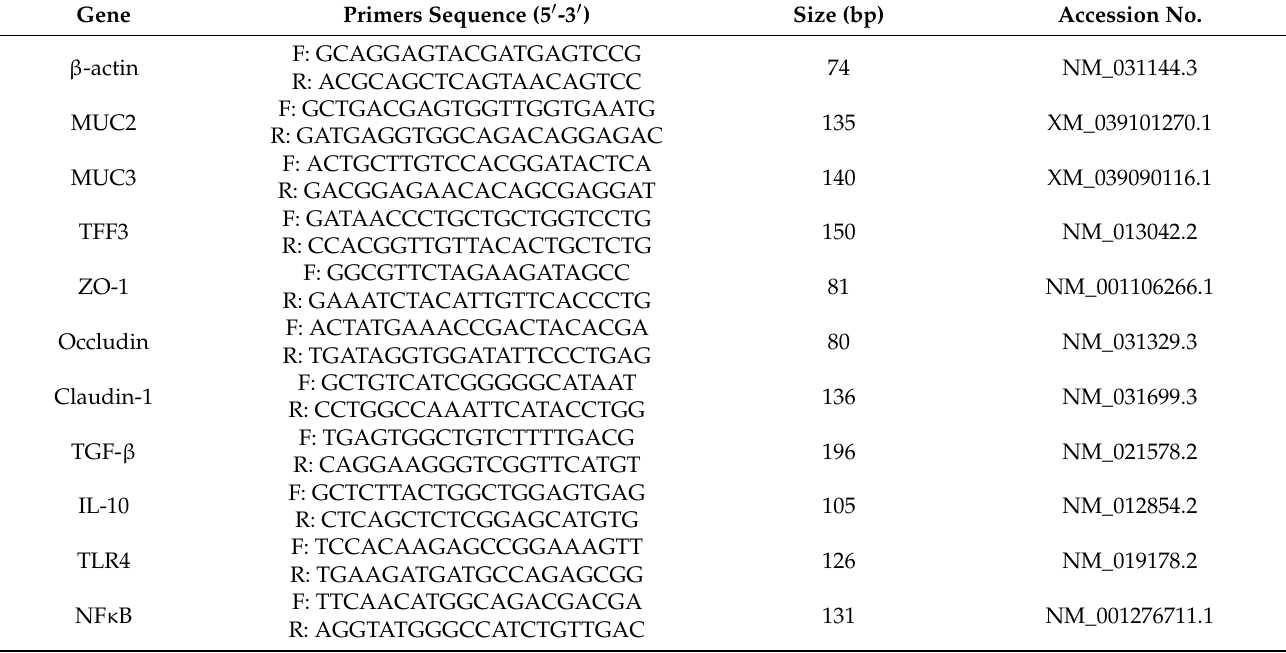
Table 1. Primers used for